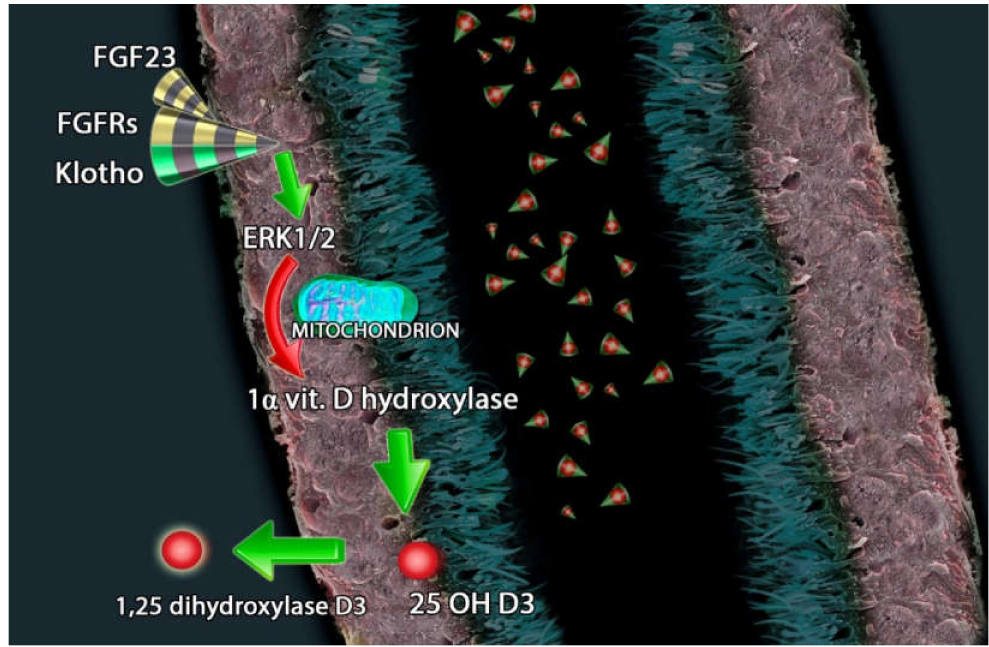
Figure 2. FGF23 (fibroblast growth factor-23), FGFRs (FGF receptors) and Klotho counter regulate the hydroxylation of 25(OH)D3 through extracellular signal-regulated kinases 1 / 2 and the inhibition of